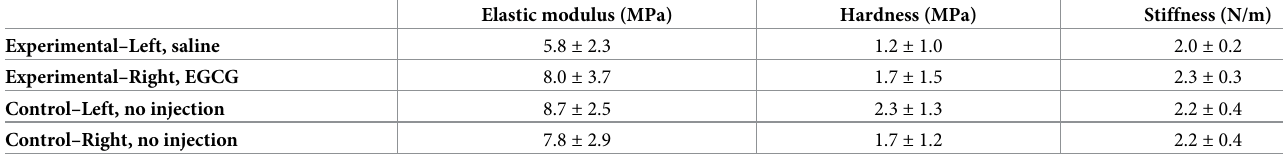
Table 3. Results of nanoindentation as raw averages for the four groups of samples for three mechanical properties.